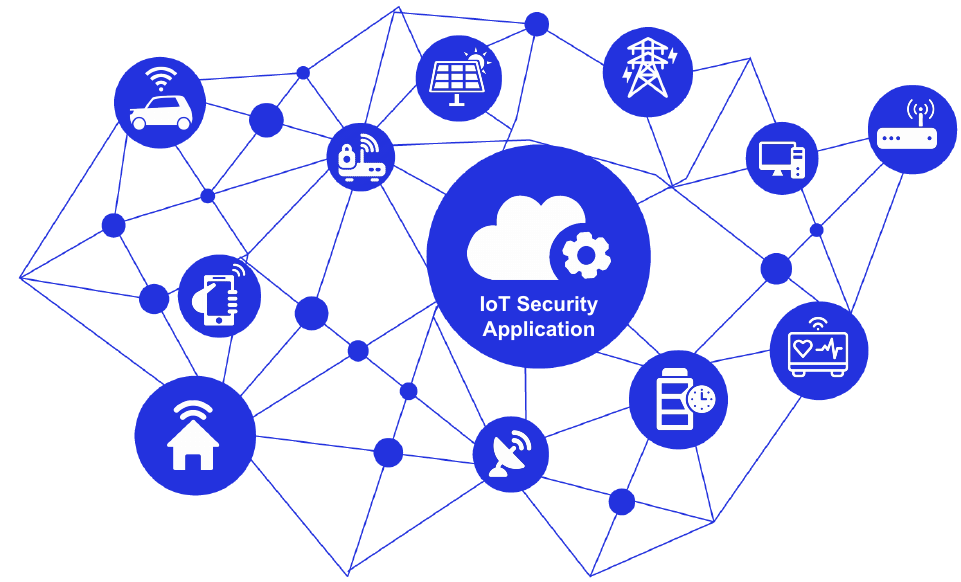
Figure 1. Wearables, implants, automobiles, machines, smartphones, appliances, computing systems, and other items are all capable of collecting data securely over a network. They are also able to respond to remote orders and take actions depending on collected